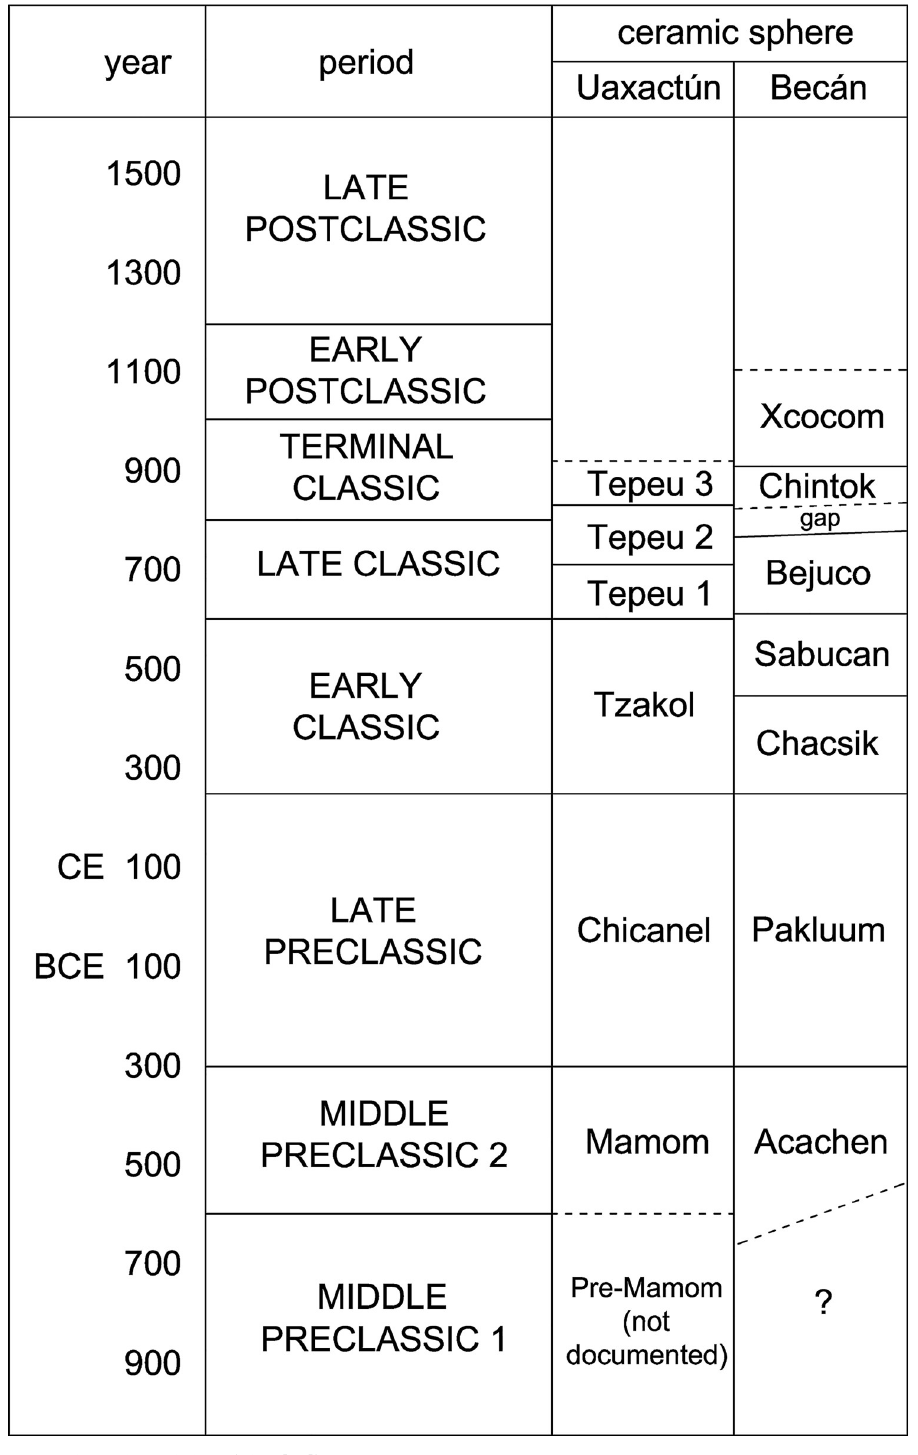
Fig 3. Chronological chart (after